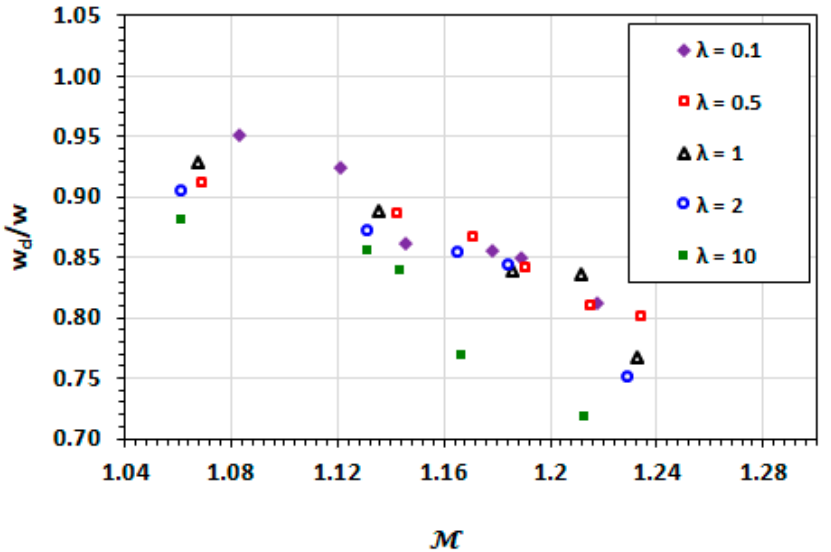
Figure 13. Dependence of the non-dimensionalised width on droplet mobility at varying viscosity ratios.